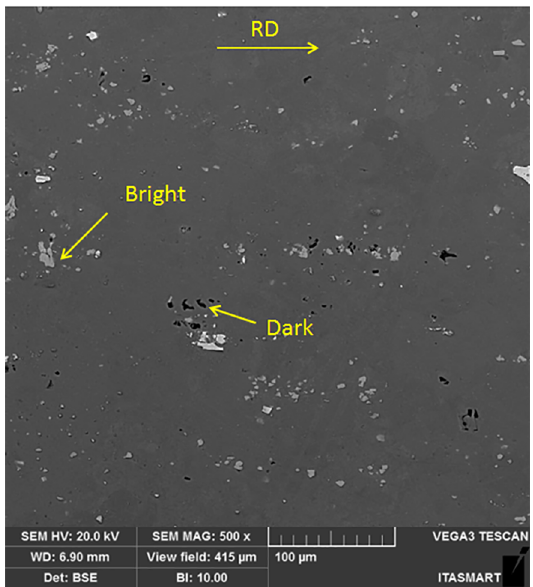
Figure 4. SEM image in the rolling direction of the AA5083-O without chemical etching, the rolling plane is parallel to the page and the rolling direction is horizontal to the page.